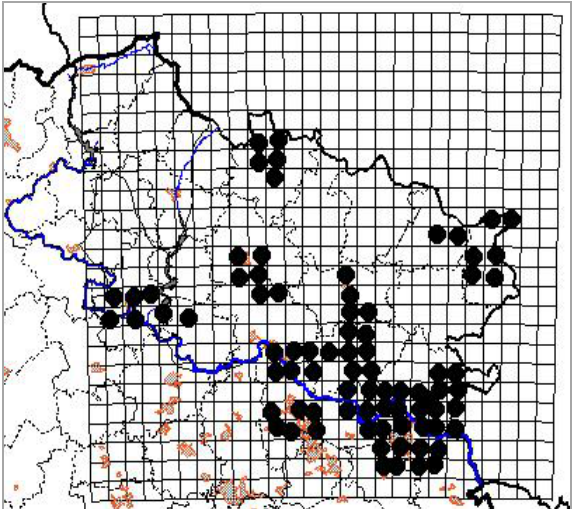
Fig. 3. The map of the distribution of Ailanthus altissima (Mill.) Swingle in the Starobilsk grass-meadow steppe